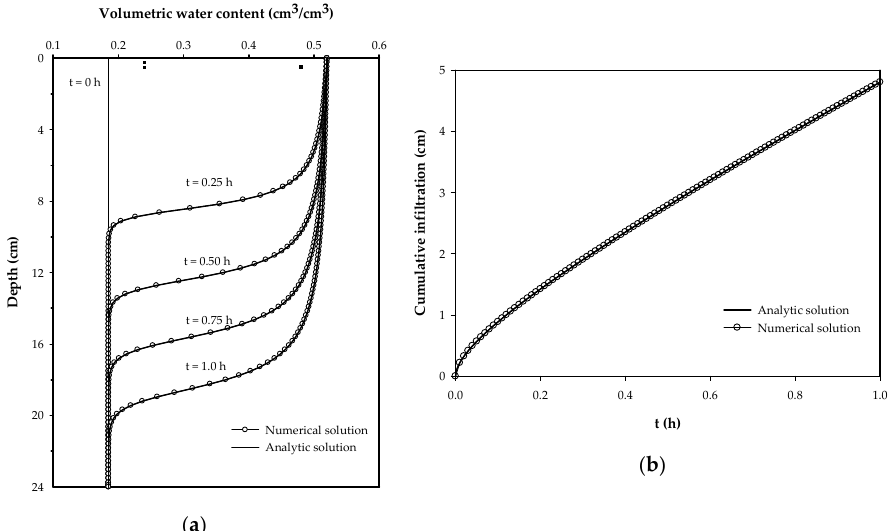
Figure 2. Moisture profiles ( a ) and cumulative infiltration ( b ) obtained via numerical and analytical solutions of infiltration in sandy loam soil of Montecillo, Mexico.